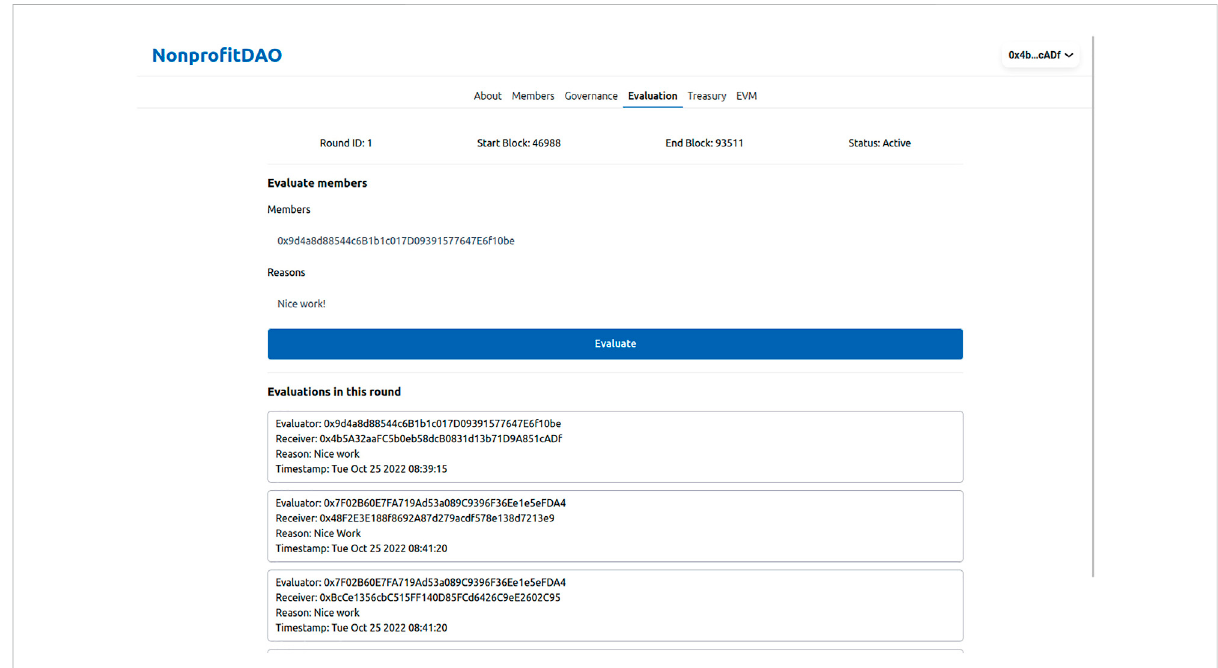
FIGURE 8 The evaluation section in the front-end software. All evaluation history is publicly